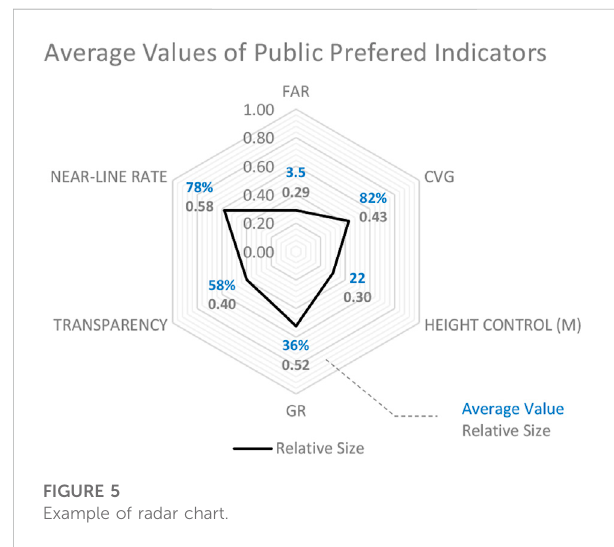
FIGURE 5 Example of radar